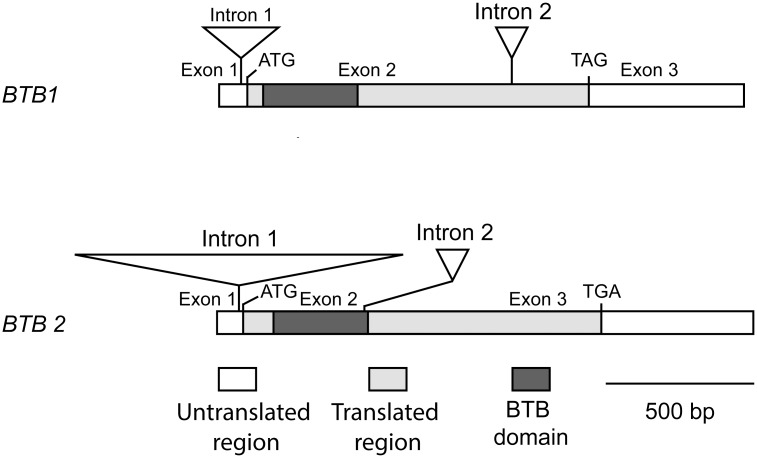
Structures of BTB1 and BTB2 transcripts.Untranslated and translated regions, exons and positions and sizes of introns are shown. The BTB domain is indicated.